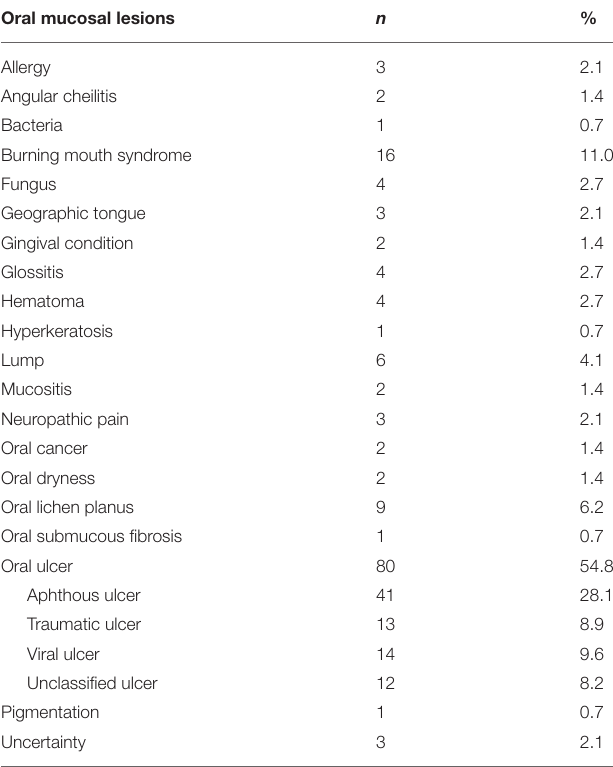
TABLE 3 | Frequencies of oral mucosal